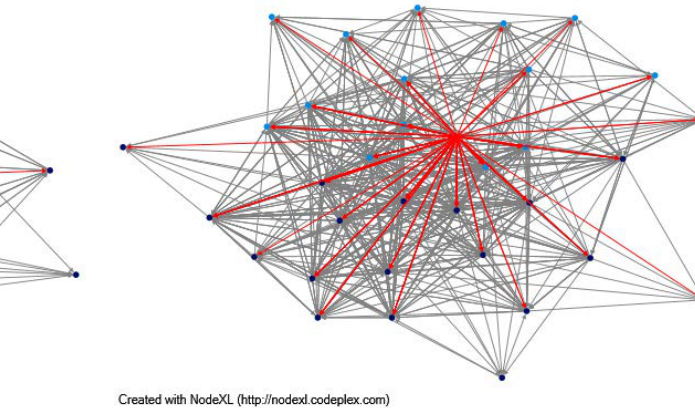
Figure 3a. A egocentric network of a “gradually mastering member” (initial four weeks)